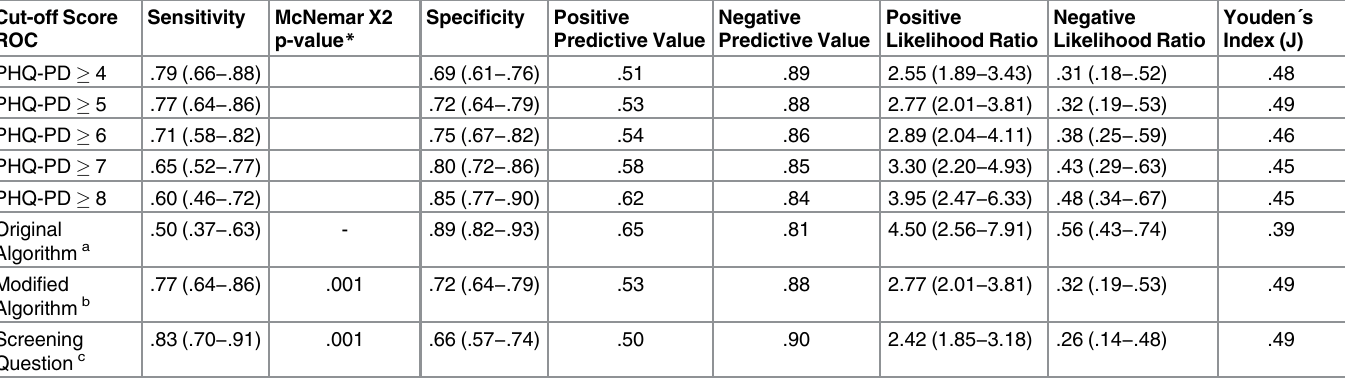
Table 3. Operational characteristics of the PHQ-TP, sensitivity and specificity, positive and negative predictive value, and positive and negative likelihood ratio. Cut-off Score